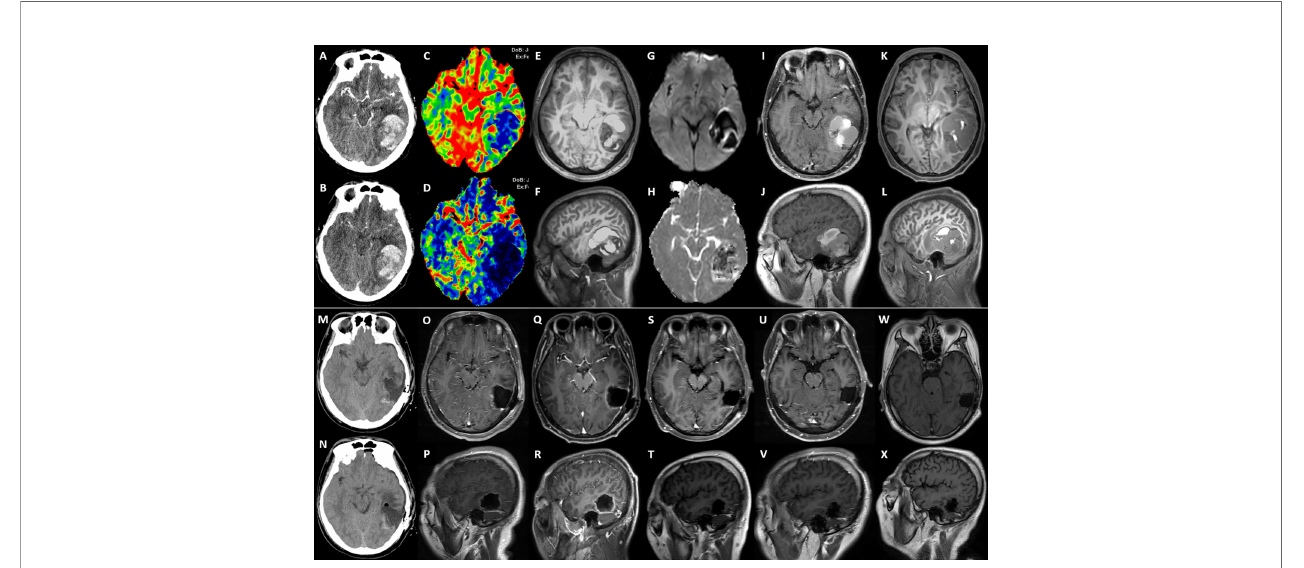
FIGURE 1 | The serial imaging of the intracranial lesion. (A – L) are preoperative images, and (M – X) are postoperative images. (A, B) The arterial phase and venous phase of cerebral CT angiography taken at onset (9 th Feb. 2020). (C, D) The volume-based and fl ow-based CT perfusion images showed relatively low perfusion status of the lesion. (E, F) The T1 weighted MRI imaging with the three-dimensional magnetization-prepared rapid acquisition with gradient echo (T1WI-3D- MPRAGE) (10 th Feb.) showed hemorrhagic cystic supratentorial neoplasm. (G, H) The b1000 and apparent diffusion coef fi cient images from diffusion-weighted imaging showed restricted diffusion within the lesion. (I, J) The T1WI MRI with contrast on 30 th Mar. identi fi ed that the hematoma was partially absorbed. (K, L) The preoperative T1WI-3D-MPRAGE MRI on 10 th Apr. showed signi fi cant absorption of the hemorrhage. (M, N) Postoperative CT scans, (O, P) , postoperative T1WI MRI with contrast, both demonstrated a gross total resection of the left temporal lesion. The periodical follow-up T1WI MRIs with contrast, including (Q, R) (29 th Apr.), (S, T) (17 th Jul.), (U, V) (28 th Oct., before cervical spine surgery), and (W, X) (25 th Jan. 2021, right after thoracolumbar spine surgery, and 9 months after the neurosurgery), observed no sign of local